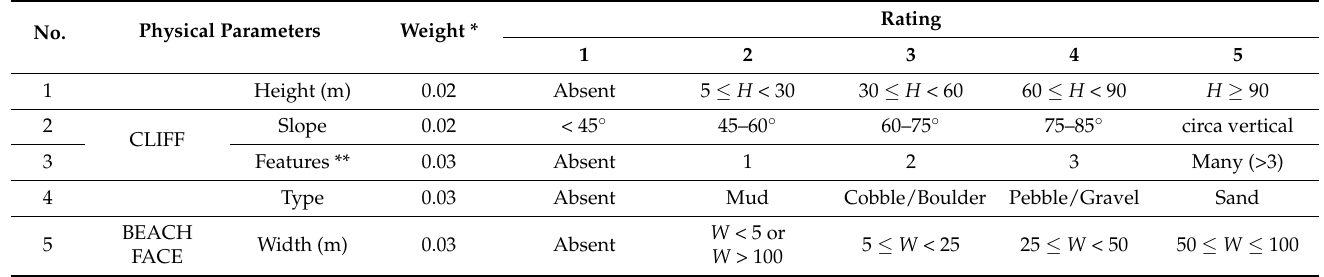
Table A1. Checklist of the 26 physical/human parameters considered by the Coastal Scenery Evalua- tion System (CSES) method; applied in >40